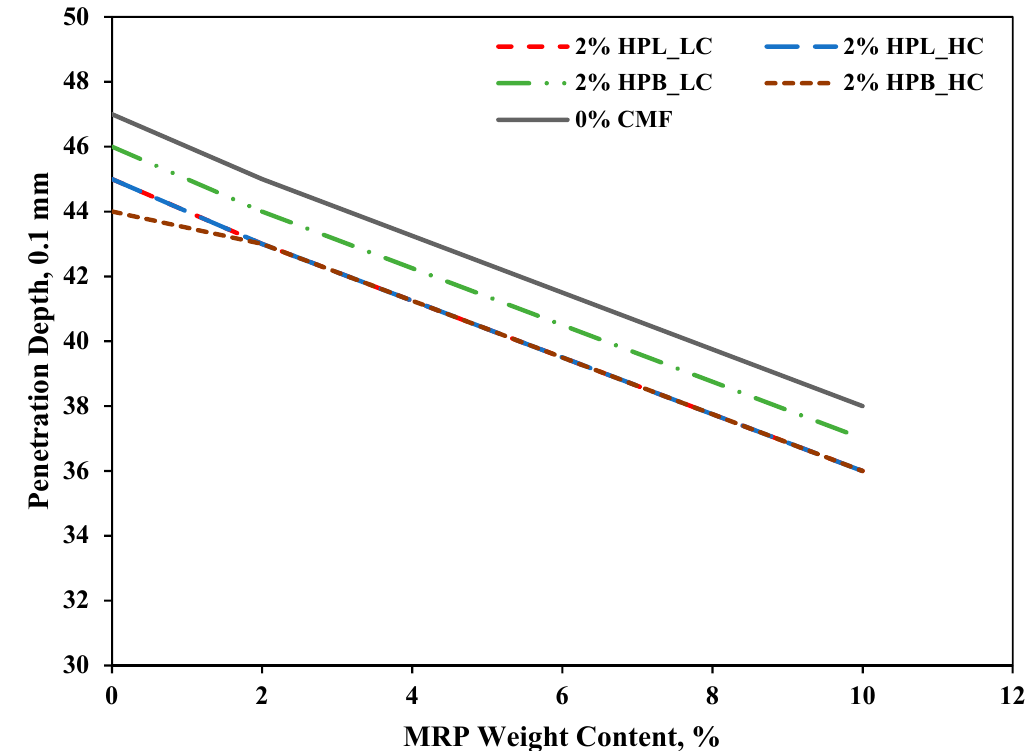
Figure 3. Effect of micronized rubber powder (MRP) content and cellulose microfibrils (CMF) type on penetration depth at 0% and 2% CMF content.